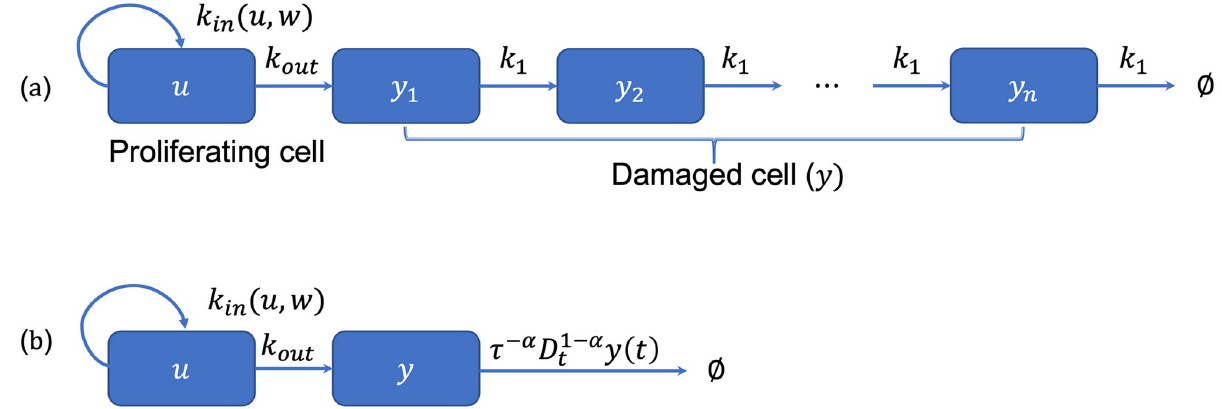
Fig 1. Schematic diagram of TCMs modeled by distributions. (a) Erlang TCM. Total tumor cells are given by w = u + y 1 + ��� + y n . (b) Fractional TCM. Total tumor cells are given by w = u + y .